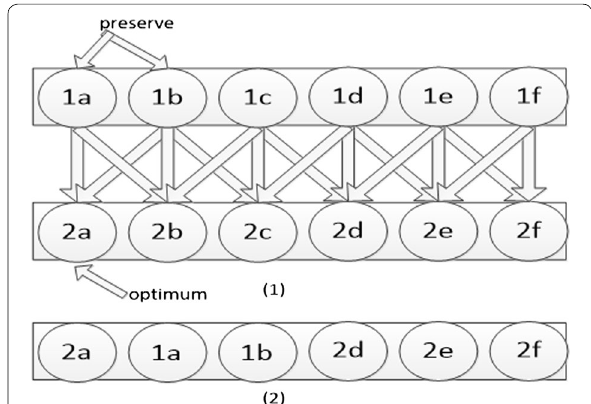
Fig. 1 Diagram of CEP. (1) The individuals of the previous generation pair and cross to generate the individuals of the next generation. The optimum individual 2a serves as an elitist individual, and its parents are preserved. (2) The adjusted individuals of the next generation after